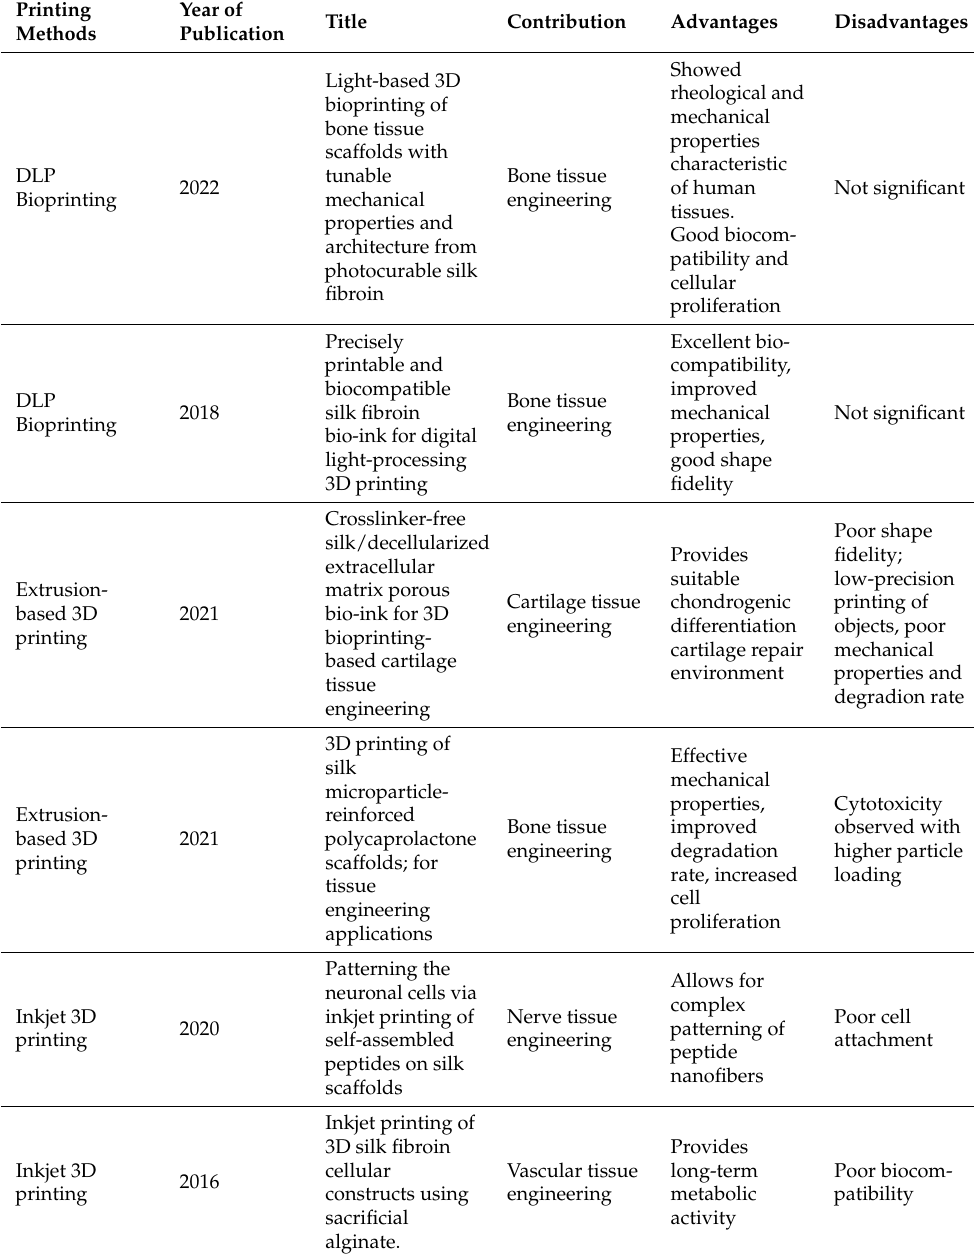
Table 3. Use of SF-based bio-ink for various biomedical applications via different 3D-printing methods